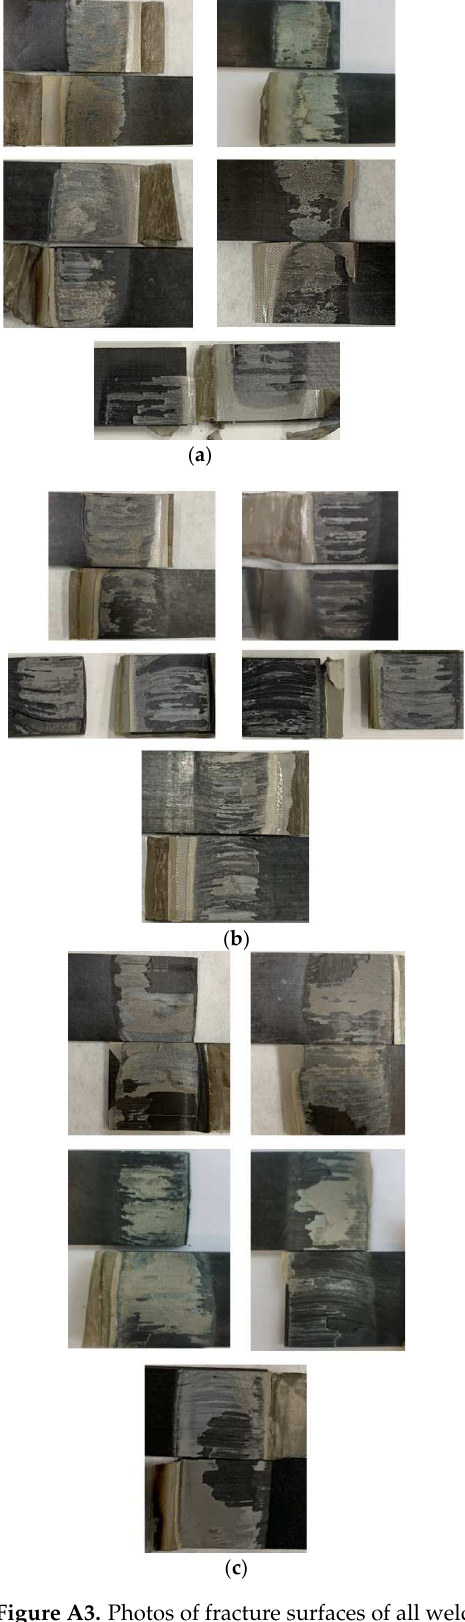
Figure A3. Photos of fracture surfaces of all welded samples obtained with type B heating element at different power densities of ( a ) 58 kW/m 2 , ( b ) 66 kW/m 2 , ( c ) 74 kW/m 2 .